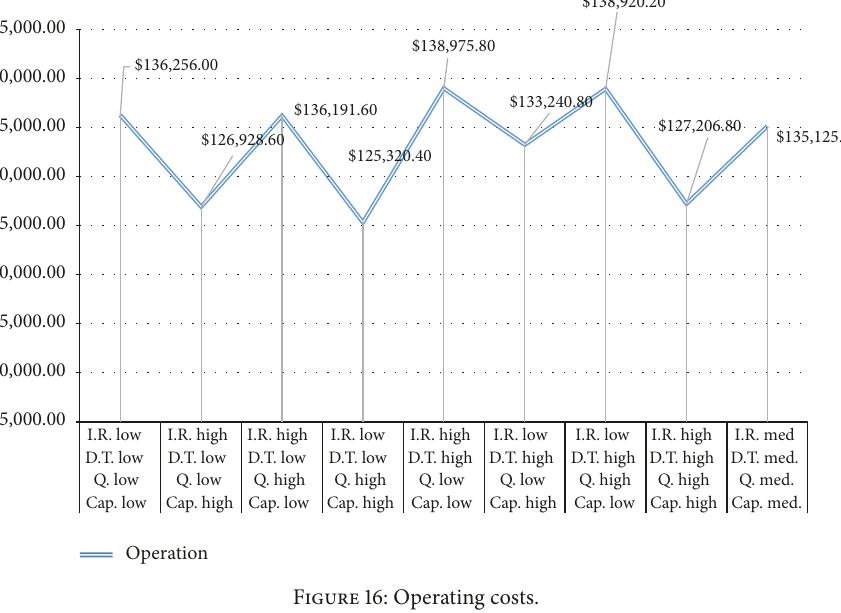
Figure 16: Operating costs.